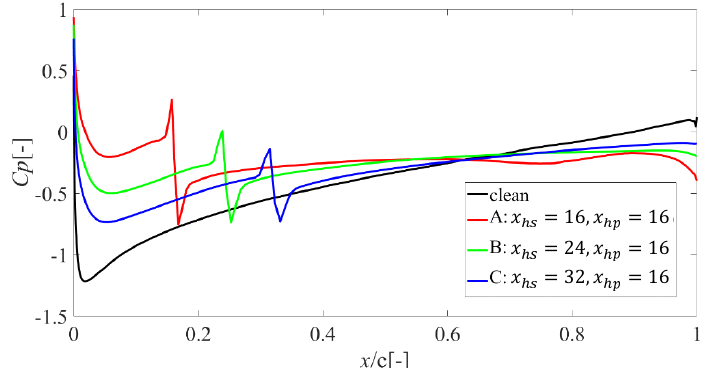
Figure 12. Pressure coefficient on the suction